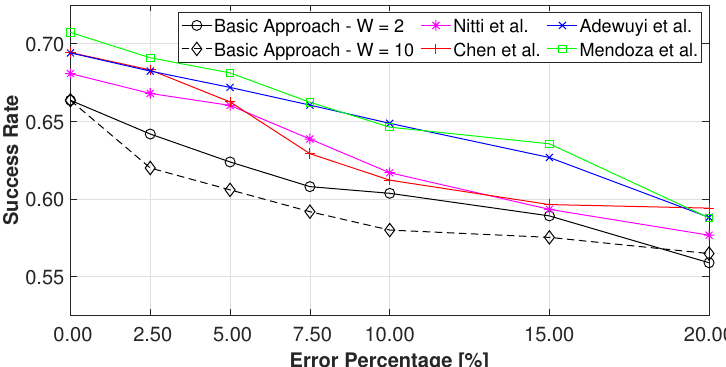
Figure 5. Transaction success rate with all types of malicious